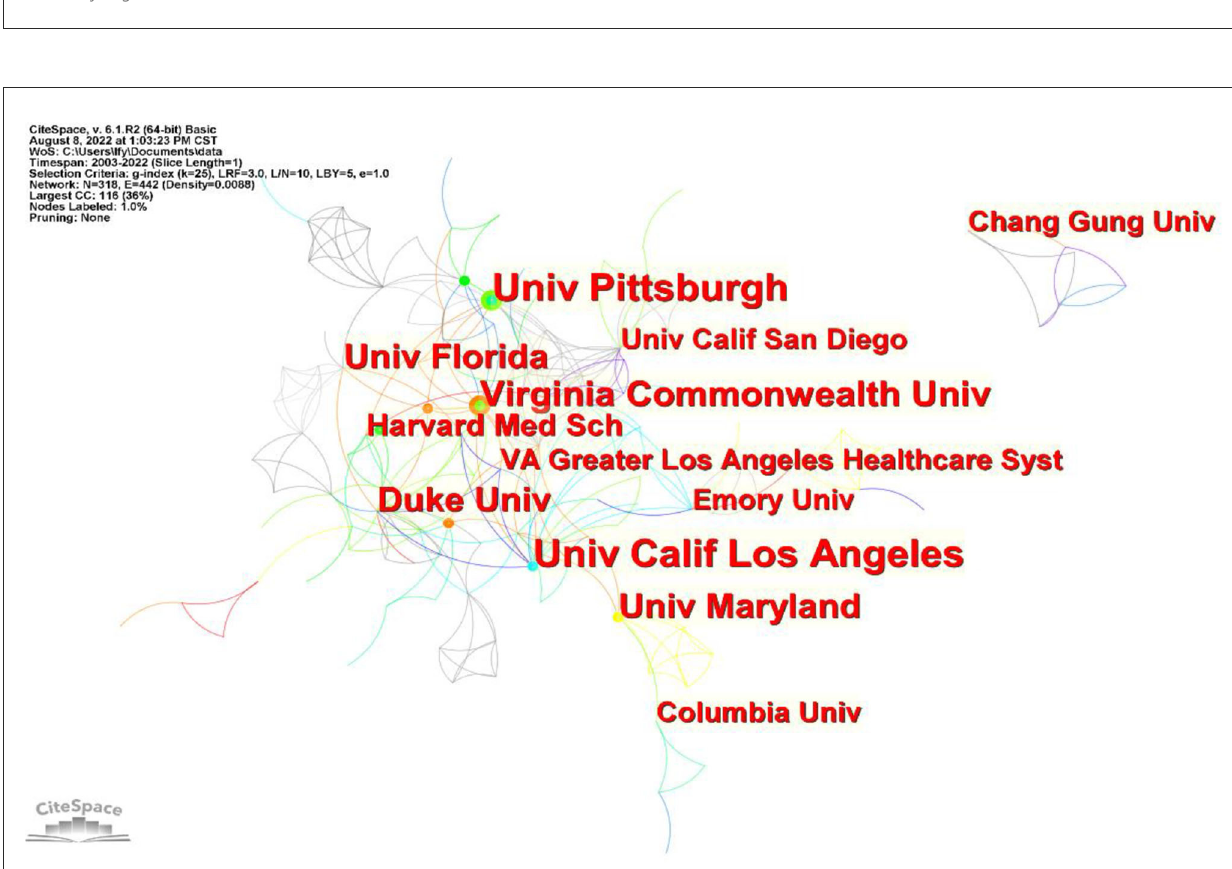
FIGURE4 Institution collaboration